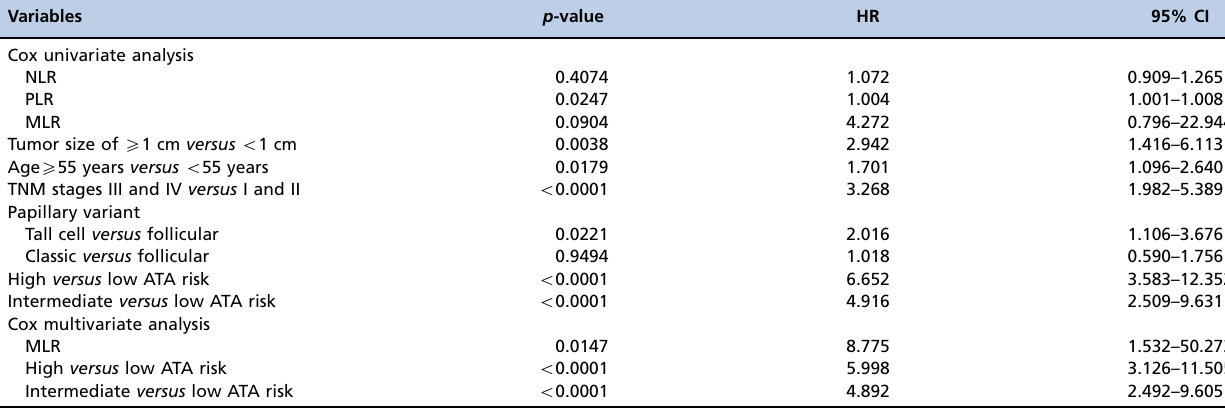
Table 3 - Factors associated with disease-free status in patients with differentiated thyroid cancer.